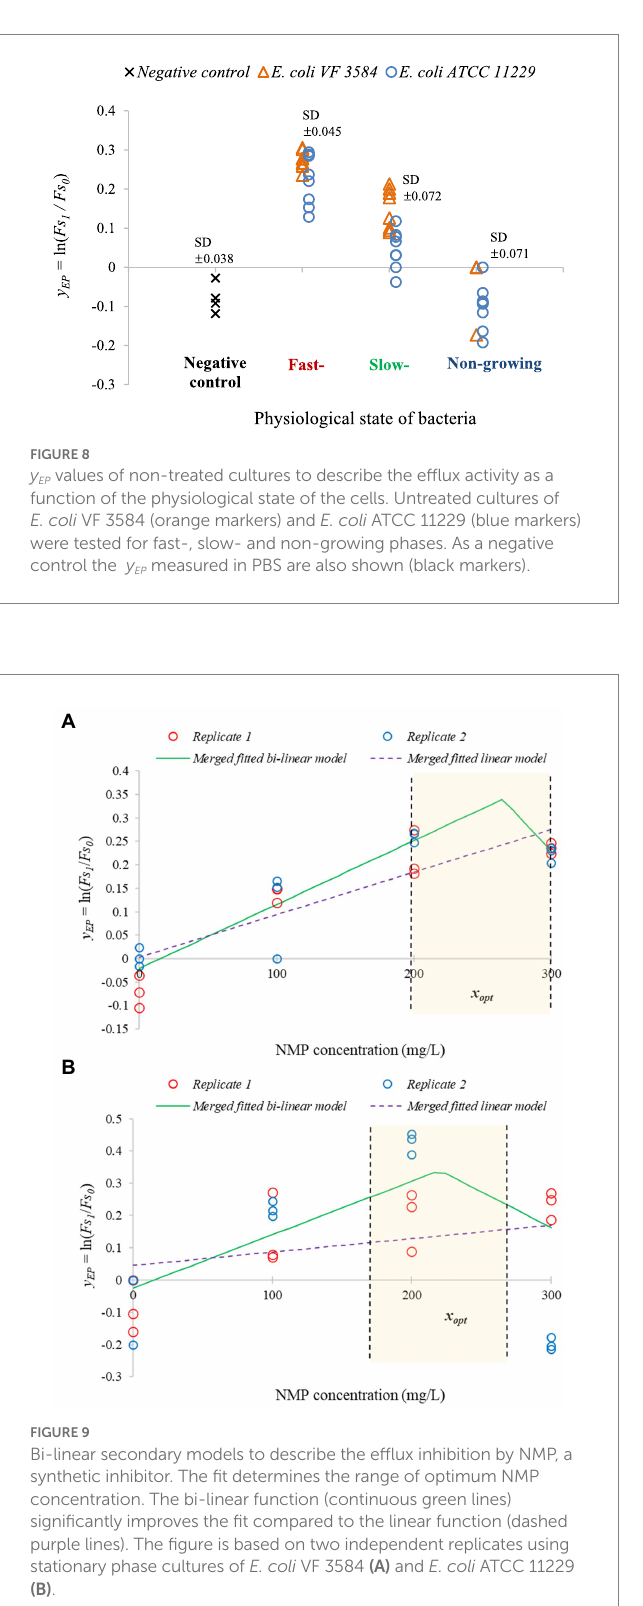
tested only in 22 mg/l concentration. To compare the inhibitor efficacy of carvacrol with that of synthetic inhibitors, we created Figure 10, representing the differences between the respective